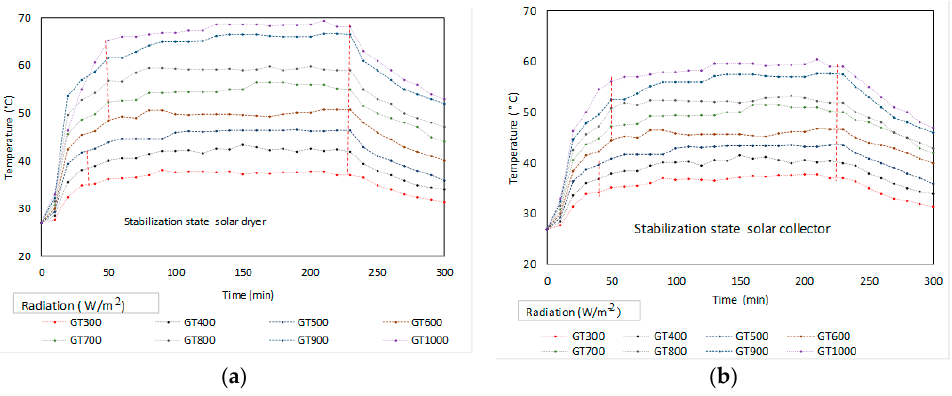
Figure 2. Average temperature reached in the ( a ) drying chamber and ( b ) solar collector.